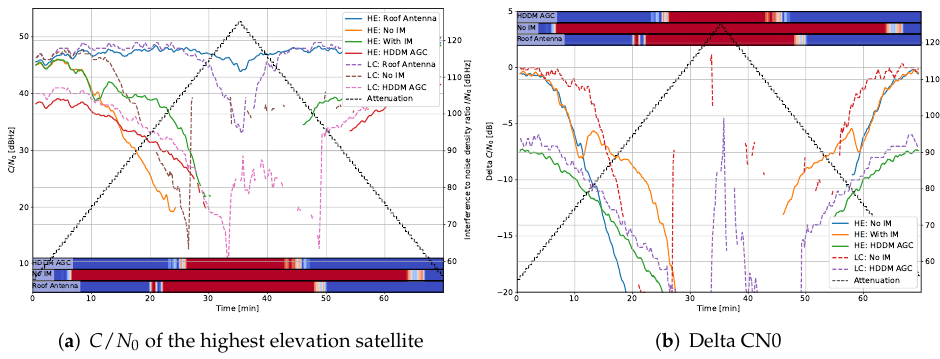
Figure A1. Interference #1: CW 1 575.42 MHz with GPS L1/CA.